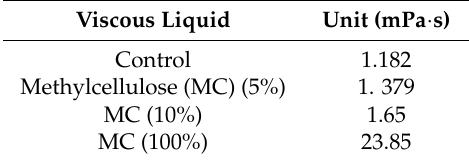
Table 1. Viscosity measurement of the concentration of methylcellulose (MC) used in the experiment. Viscous Liquid